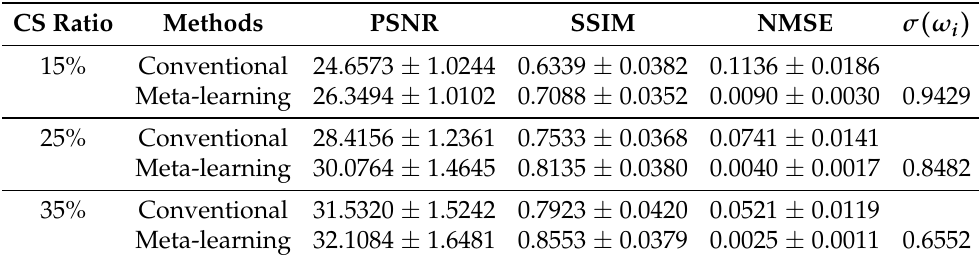
Table 3. Quantitative evaluations of the reconstructions of T1 brain image associated with various sampling ratios of radial masks. Meta-learning was trained with CS ratios of 10%, 20%, 30%, and 40% and tested with unseen ratios of 15%, 25%, and 35%. The conventional method was subjected to regular training and testing with the same CS ratios of 15%, 25%, and 35%.